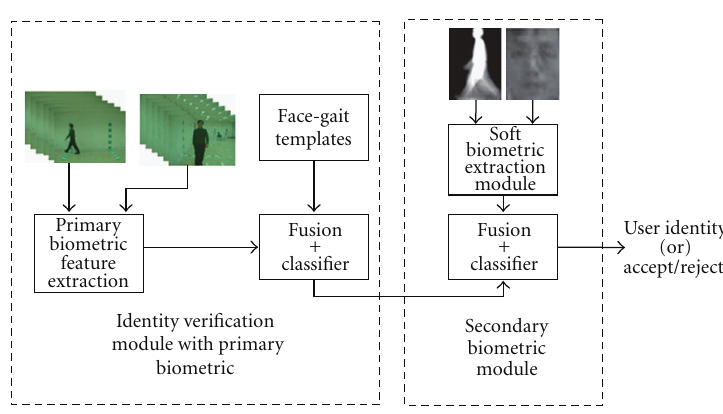
Figure 5: Identification using face-gait